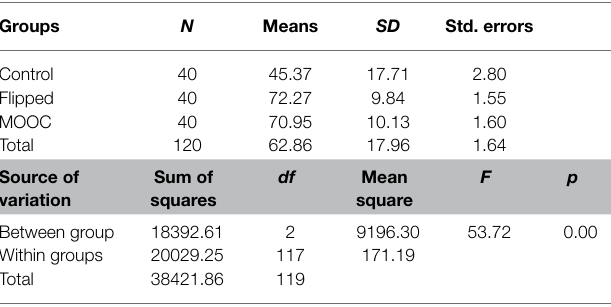
TABLE 3 | ANOVA results for anxiety post-test.